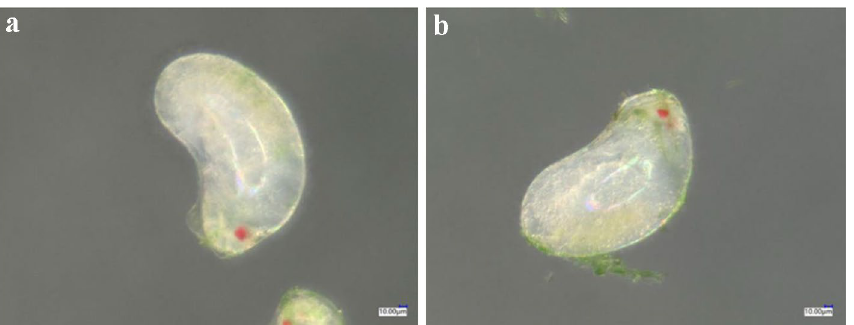
Figure 4. The effect of spirotetramat on external morphology living of 24-h-old eggs of F. occidentalis . ( a ) Normally developing 24-h-live eggs in the control group; ( b ) live 24-h-old eggs after spirotetramat